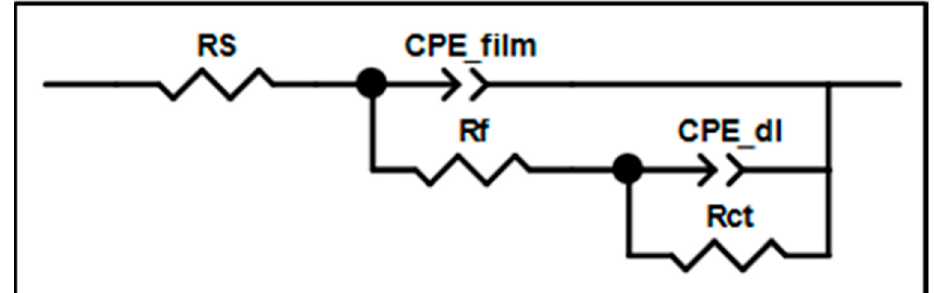
Figure 4. EIS equivalent circuit diagram.